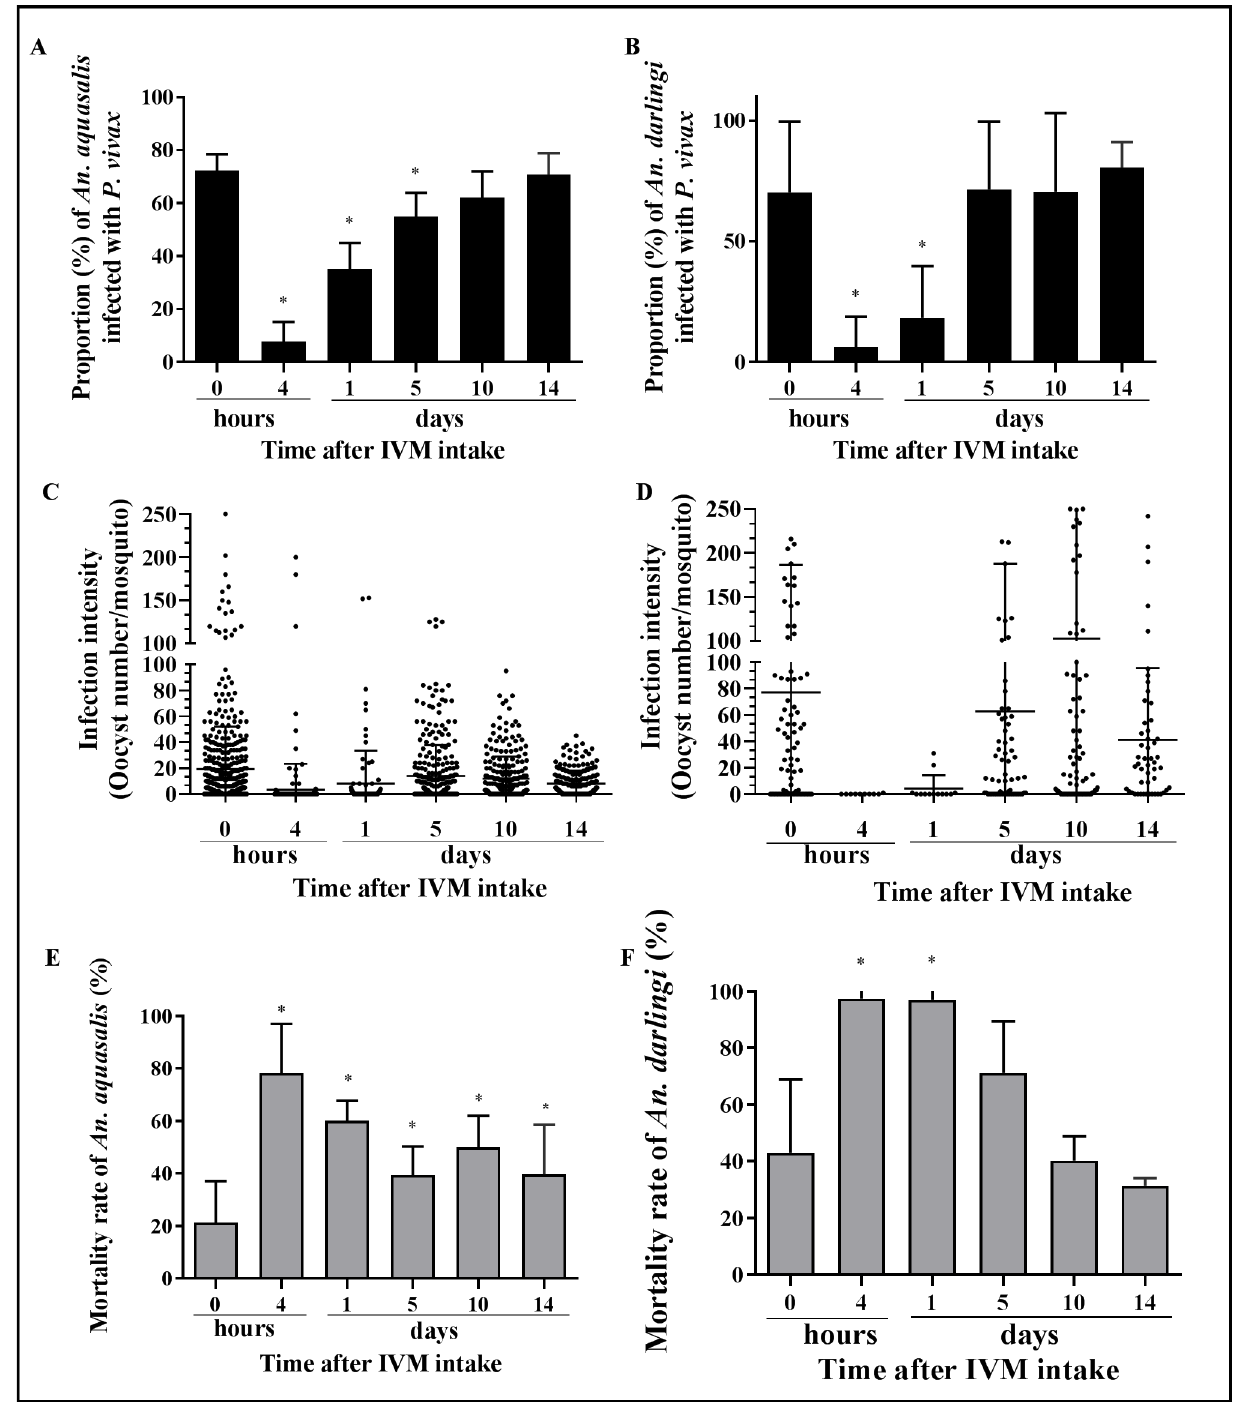
Fig 3. Ivermectin metabolized affects Plasmodium vivax development in Anopheles aquasalis and Anopheles darlingi . An . aquasalis (A,C,E) and An . darlingi (B,D,F) mosquitoes were fed P . vivax with mIVM collected at various time points (0 and 4 hours; 1, 5, 10 and 14 days). (A) and (B) Proportion of P . vivax infected mosquitoes are presented as mean and standard deviation. (C) and (D) The intensity of infection is presented as the number of oocysts per a single midgut (black dots) and the black lines represent the median and standard deviation. (E) and (F) The mosquito mortality rate is presented as mean and standard deviation. Data from 5 independent experiments are presented. Asterisks ( (cid:3) ) represent significant difference (P < 0.05) in relation to the control.